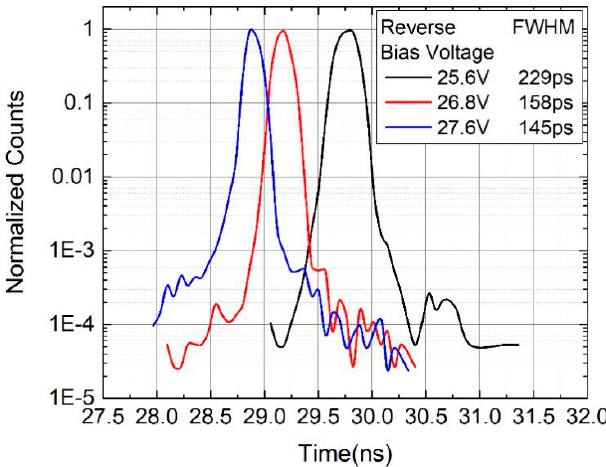
Figure 11. Experimental setup for measuring timing response of the module.